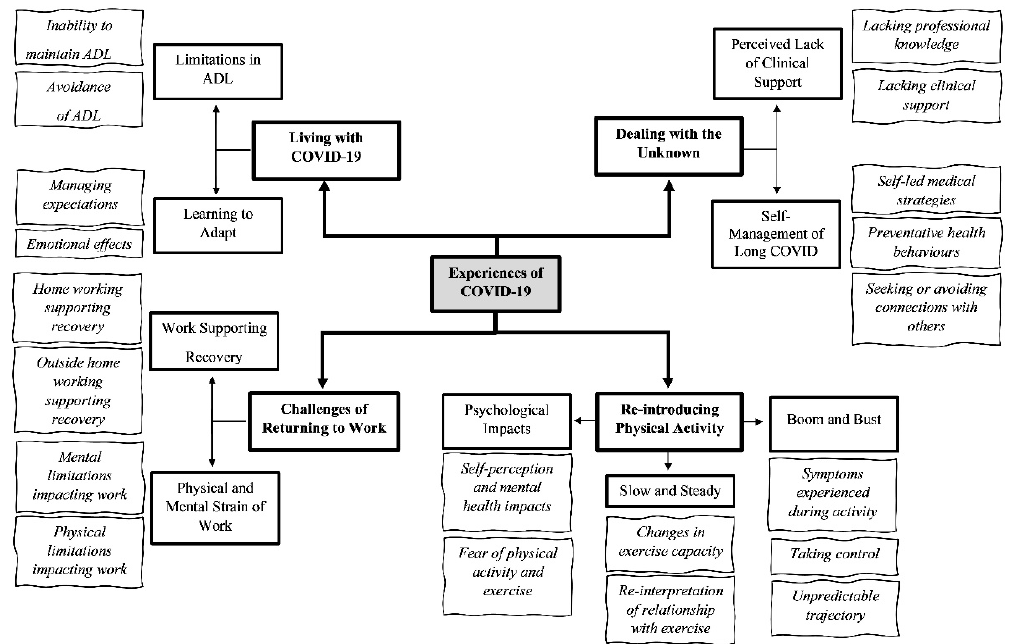
Figure 1. Displaying the four overarching themes (bold text and box), sub-themes (standard font and bold box), and codes (italic text) identified from semi-structured interviews exploring individuals’ experiences of COVID-19 and the perceived impact on physical activity.